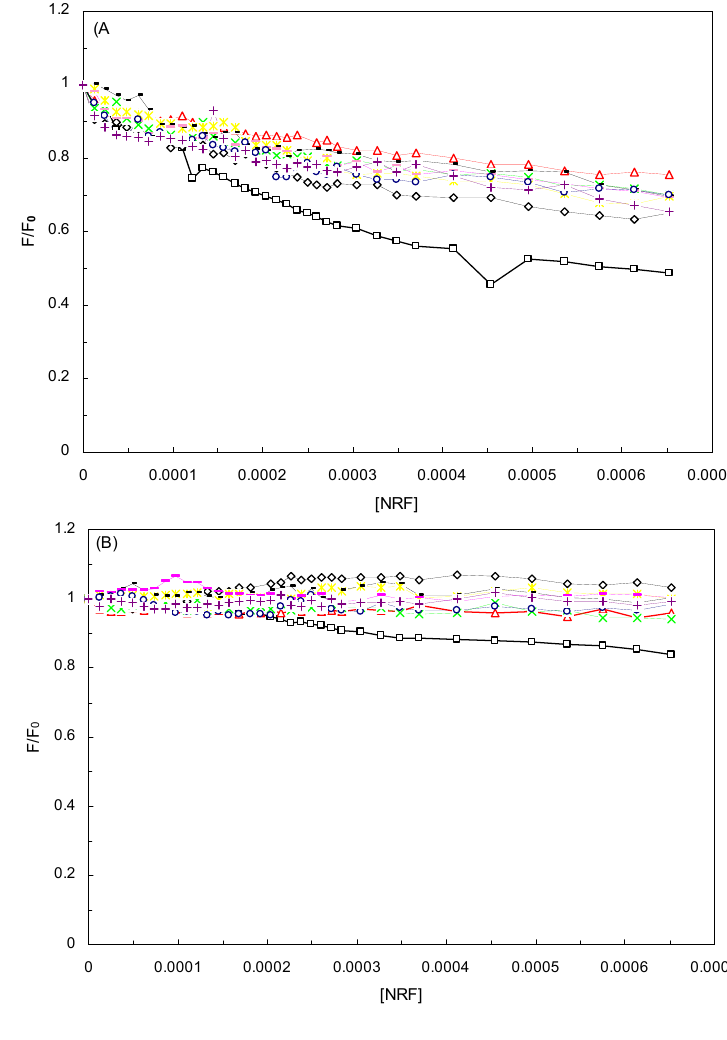
Figure 5. Synchronous fluorescence spectra of the quenching of HSA by NRF in the absence and presence of EMFs, T = 298 K; pH 7.40. HSA-NRF( □ ), 100 Hz/2.4 mT( ◊ ), 100 Hz/6.4 mT( ∆ ), 1 KHz/0.98 mT( (cid:31) ), 1 KHz/1.9 mT( (cid:31) ), 10 KHz/0.17 mT (-), 10 KHz/63 μ T (_), 100 KHz/39 μ T ( ○ ), 1 MHz/59 μ T (+), (A) in Δλ = 60. (B) Δλ =